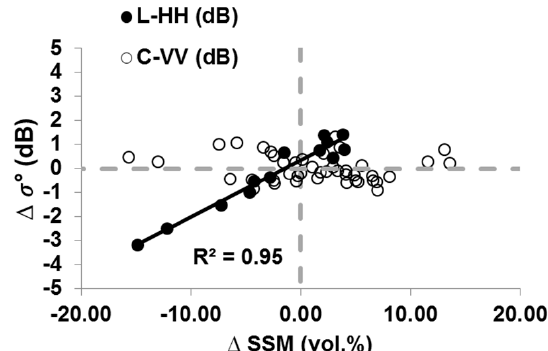
Figure 5. ∆ σ 0 (difference in σ 0 between two successive dates) in the L and C bands versus ∆ SSM (corresponding difference of SSM) for reference plots of wheat and grassland with an NDVI greater than 0.7. Positive ∆ σ 0 and ∆ SSM correspond to increases between two successive dates of σ 0 and SSM, respectively.